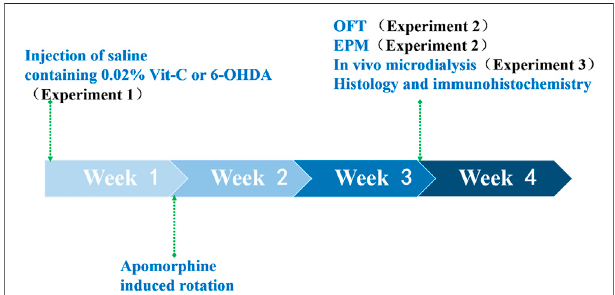
FIGURE 1 | We fi rst validated the effectiveness of the PD rat model. SNc-lesion ( n = 23) and sham-operated ( n = 24) rats were used to demonstrate that 6-OHDA microinfusions into the SNc and VTA caused a signi fi cant reduction in the number of TH-ir neurons in both brain areas using immunohistochemistry. First, the brain sections were blocked with 3% bovine serum albumin (BSA) in PBS containing 0.3% Triton X-100 at room temperature for 0.5 h and then incubated with anti-TH monoclonal antibodies (1:800, Chemicon, CA, USA) at 4 ° C for 48 h. Next, the brain sections were incubated with biotinylated anti-mouse IgG (1:200, Chemicon) for 2 h and then with avidin – biotin – peroxidase complex (1:100, Vector Laboratories, CA, USA) for 2 h at room temperature. Finally, they were exposed to a solution of 0.05% 3,3 ′ -diaminobenzidine (Sigma-Aldrich) containing 0.01% H 2 O 2 for 10 – 15 min at room temperature, serving as chromogen in the subsequent visualization reaction. After TH staining, the brain sections were rinsed, mounted onto gelatin-coated slides, dehydrated, cleared in xylene and coverslipped. Then counting the dopaminergic neuron bodies in the SNc and VTA was performed within the representative two sections per animal. A neuron was considered when intact, round with clear nucleus and/or cytoplasm. The full extent of the structure in each section was investigated in both the lesioned and non-lesioned hemisphere. Only the sections where the lateral and medial parts ofthe VTA and SNc were clearly divided by the medial terminal nucleus of the accessory optic tract level were chosen for the further analysesoftyrosinehydroxylaseimmunoreactive(TH-ir)neurons.Onlytherats with a total or subtotal loss of TH immunoreactivity within the SNc were taken for analyzing electrophysiological recordings (Wang et al.,